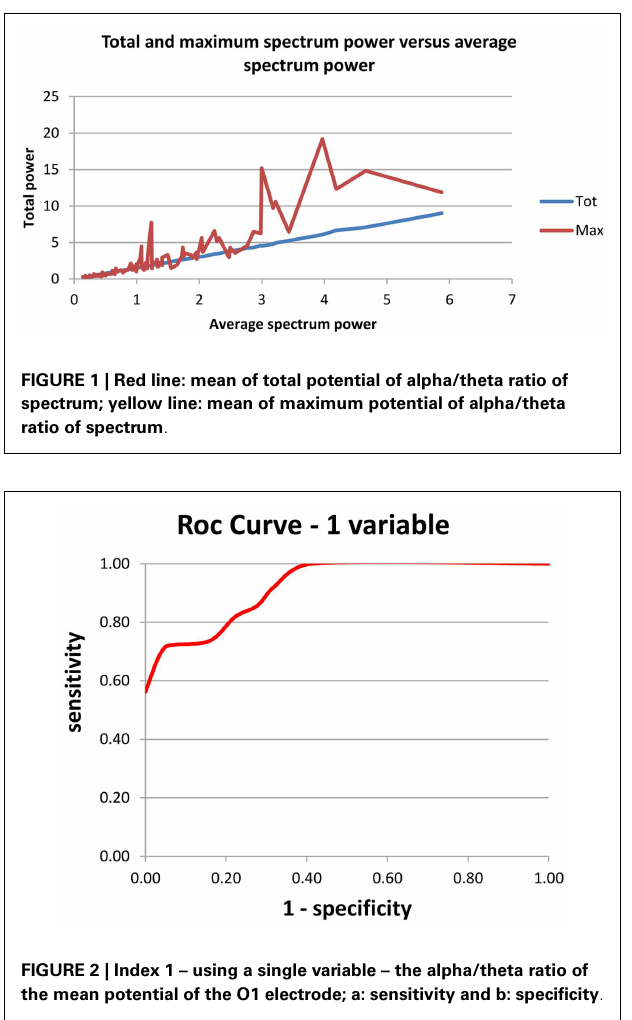
among subjects classified as Normal on the test, the result was correct in 82% of cases.